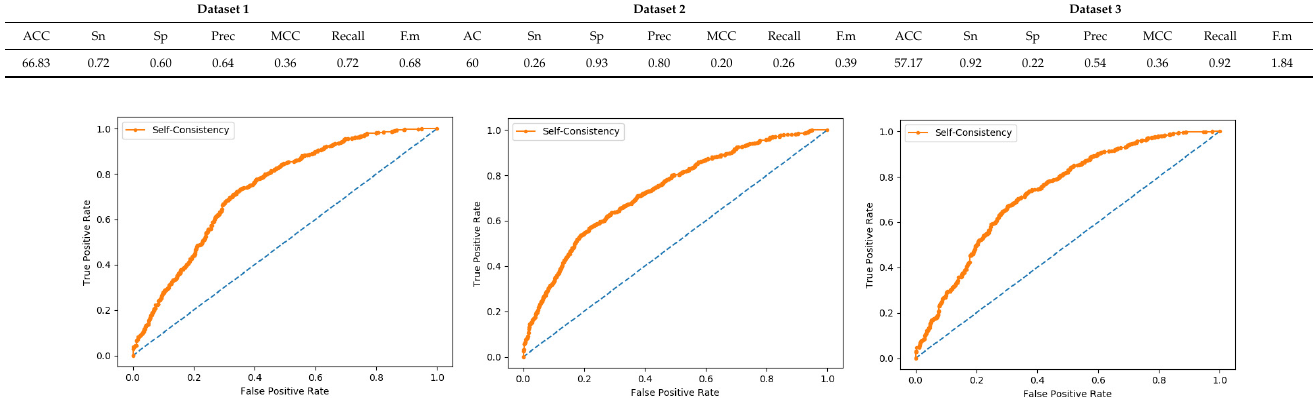
Figure 11. Self- consistency Probabilistic Neural Network ROC curve.